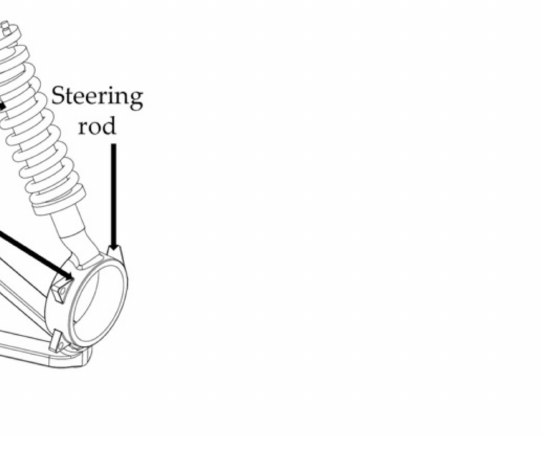
Figure 7. Typical front suspension systems: ( a ) McPherson; and ( b ) double wishbone.